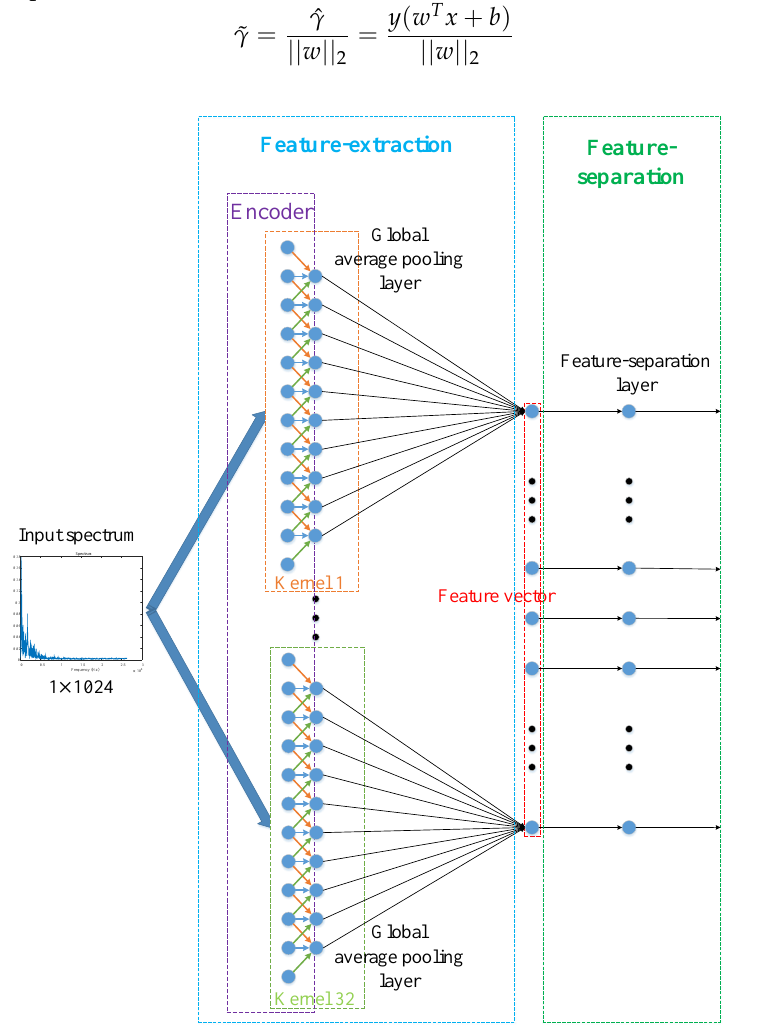
Figure 6. Procedure of the supervised feature-separation algorithm for